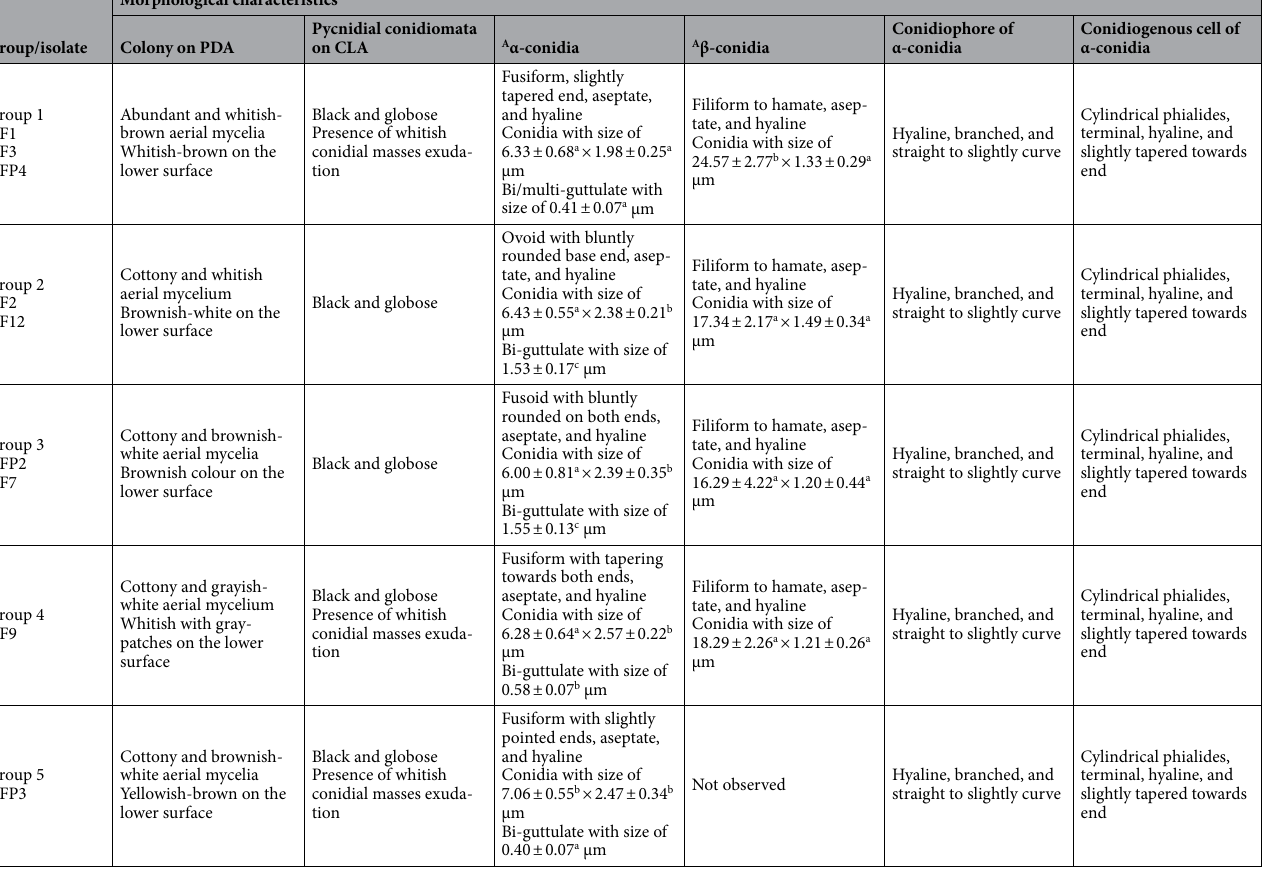
Table 1. Morphological characteristics of five different groups of Diaporthe isolates recovered from stem gray blight of H. polyrhizus. A Means ± standard deviation followed by different letters within the column are significantly different ( p < 0.05) according to Tukey’s